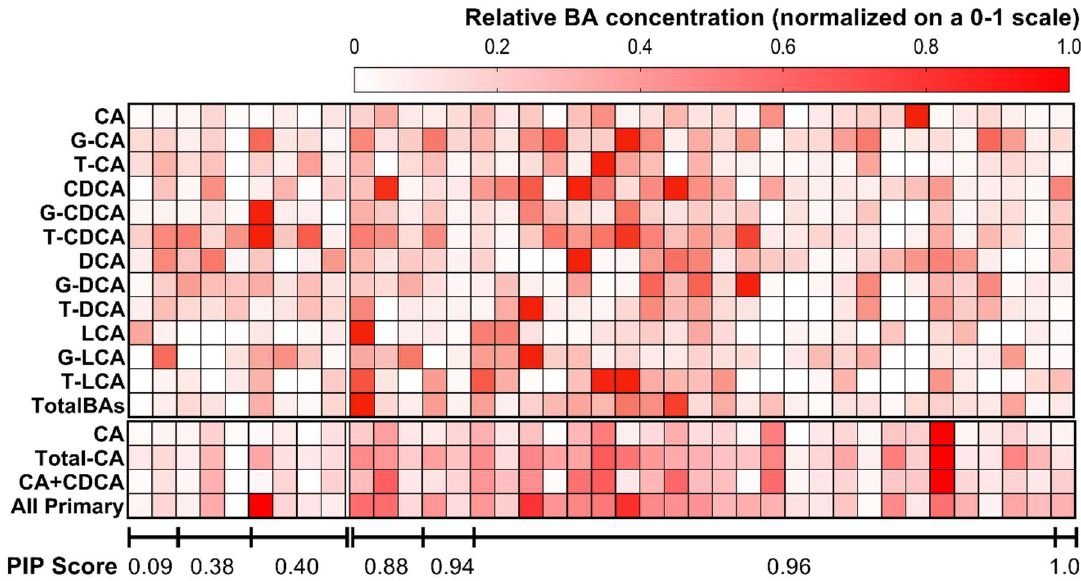
Figure 4. Distribution of bile acids according to each patient’s ( x -axis) pancreatic insufficiency prevalence (PIP) score (mild: ≤ 0.40 vs. severe: PIP > 0.40). In this figure, for illustrative purposes, concentrations of bile acids (color scale) are normalized on a zero (minimum) to one (maximum) scale. CA: cholic acid; G-CA: glycocholic acid; T-CA: taurocholic acid; CDCA: chenodeoxycholic acid; G-CDCA: glycochenodeoxycholic acid; T-CDCA: taurochenodeoxycholic acid. Concentrations of total BAs in serum were significantly higher in pwCF with severe CFTR genotypes (2.1-fold; p = 0.033), as measured by the PIP score. More specifically, free CA concentrations were found to be 3.4-fold higher in pwCF with severe CFTR genotypes ( p = 0.009). In a similar way, total CDCA tended to be lower in pwCF with mild CFTR genotypes, although this result did not attain statistical significance (0.5-fold; p = 0.123). Correspondingly, G-CA tended towards higher values in pwCF with severe CFTR genotypes without reaching statistical significance (1.5-fold; p = 0.123). The sum of all CA concentrations, i.e., CA+G-CA+T-CA, was 2.7-fold higher in pwCF with severe CFTR genotypes than in those with the mild CFTR genotype ( p = 0.004) (Figure 2 and Table 2). Table 2. Serum primary bile acids in pwCF classified according to their pancreatic insufficiency prevalence (PIP) score (median and [Q 1 , Q 3 ]). Serum Bile Acids (μmol/L) and Ratios Mild CFTR Genotype (PIP ≤ 0.4) Severe CFTR Genotype (PIP 0.88)